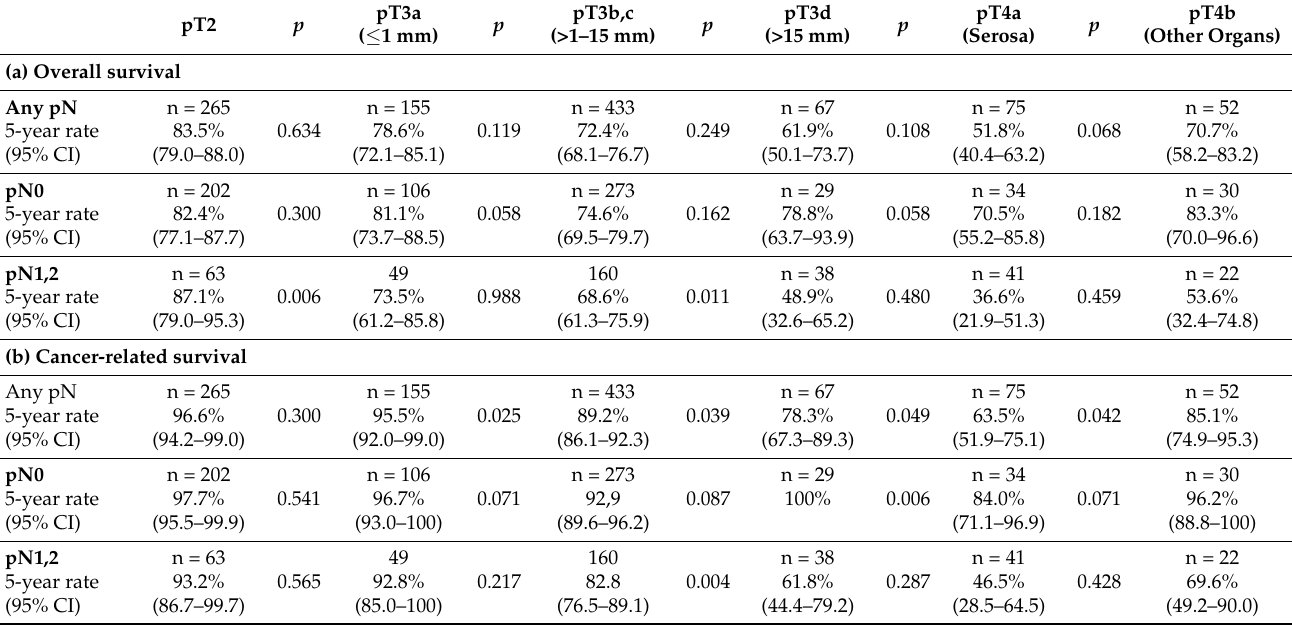
Table 4. Overall survival and cancer-related survival (n =